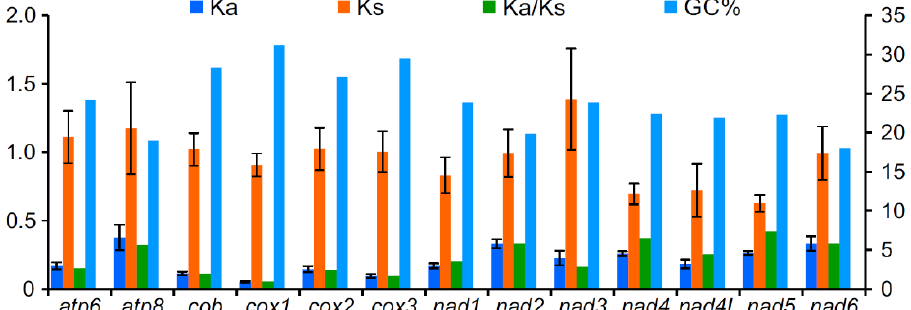
Figure 4. Evolutionary rates of 13 protein-coding genes in the mitochondrial genomes of three Pyrrhocoroidea species.